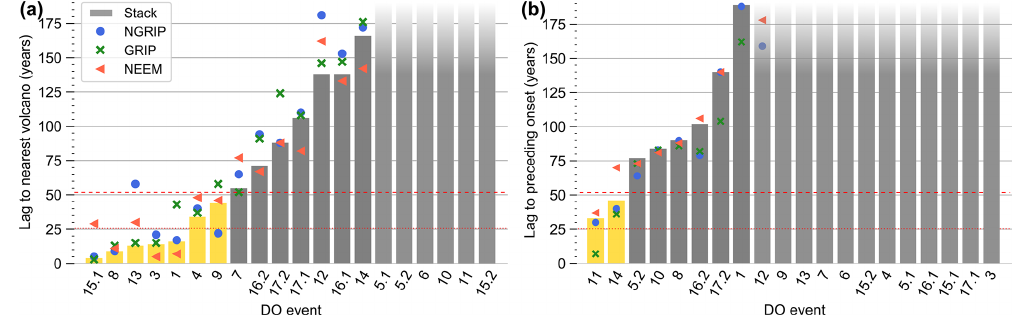
Figure 2. (a) Time lag of the DO onsets to the nearest preceding bipolar volcanic eruption. Bars and symbols indicate results for the isotope stack and individual ice cores, respectively. The yellow bars indicate events for which the onset estimate in the stack occurs within 50 years after the nearest eruption. The red dotted and dashed lines mark the 5th and 10th percentiles of the time lags for a single event under the null hypothesis, respectively. (b) Same as (a) , but considering the nearest eruptions that occur after the DO onsets.